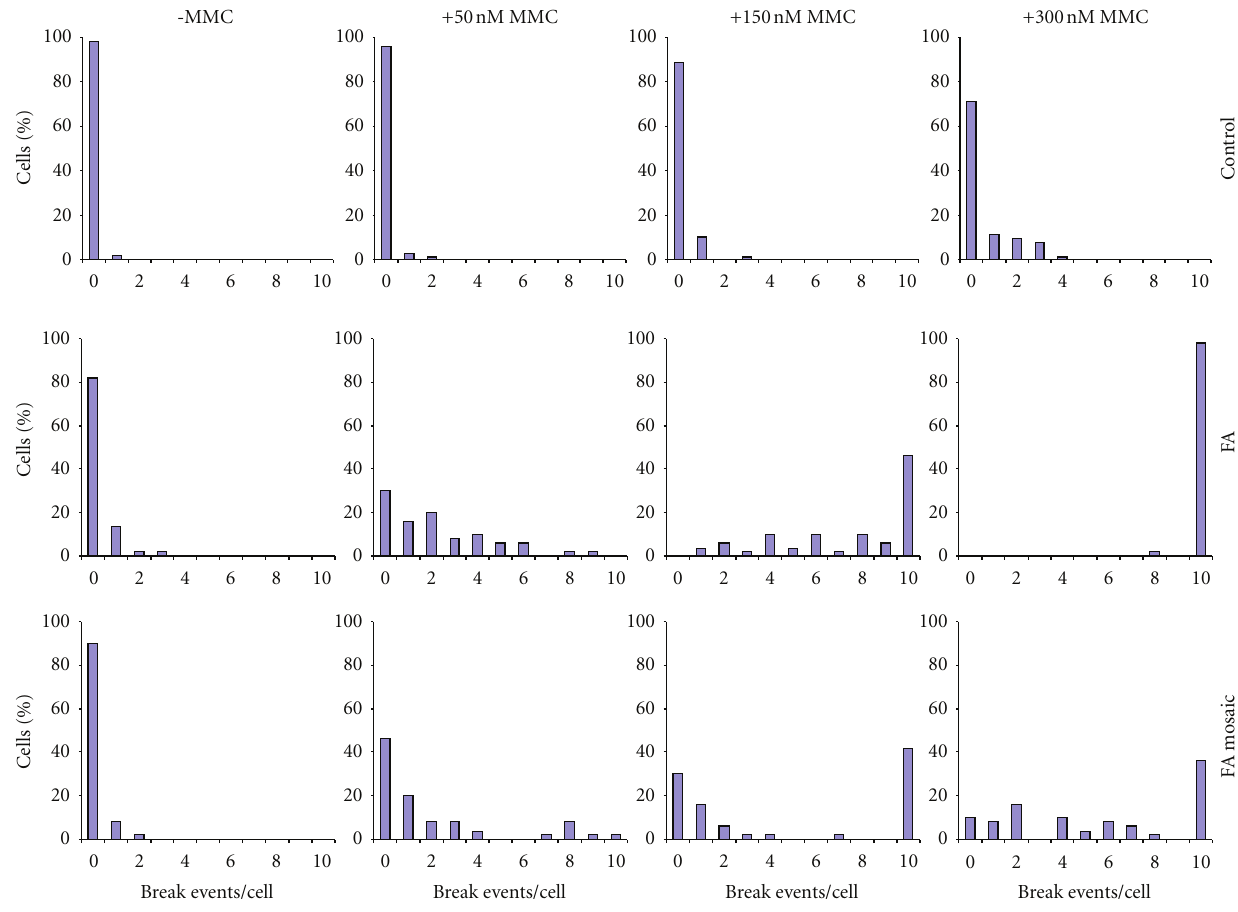
Figure 2: Evaluation of MMC-induced chromosomal breakage in stimulated T lymphocyte cultures. Upper row: healthy control; middle row: FA patient; lower row: mosaic FA patient. The healthy control shows breakage only at 300nM, where the FA patient shows massive breakage (no normal cells present). Mosaicism is evident from the two highest concentrations of MMC, where there are still normal cells present next to cells showing an FA-like breakage rate ( > 10breaks/cell). A crude estimate of the proportion of reverted T cells in this mosaic patient would be ∼